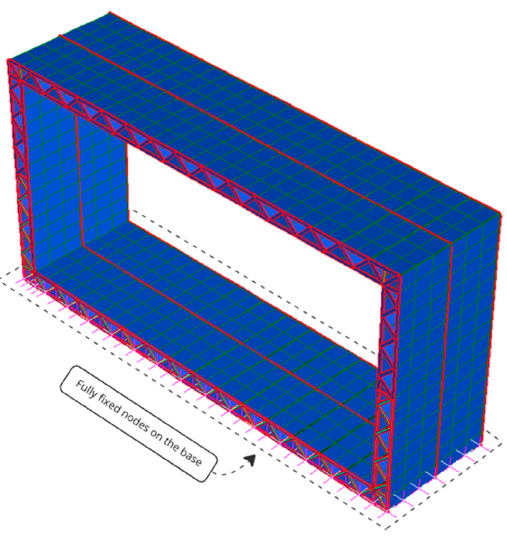
Figure 2. Fully fixed nodes on the base of the cassette to provide a foundation effect.